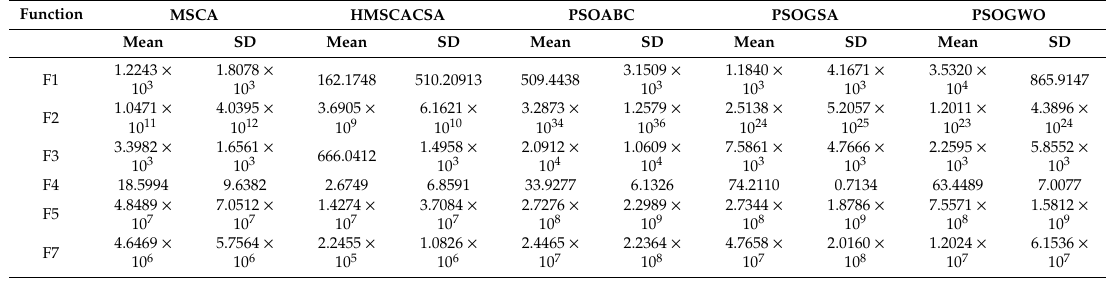
Table 4. Comparative statistical results for state-of-the-art algorithms using six benchmark functions for a population = 30, with 20 dimensions and a maximum of 1500 iterations.